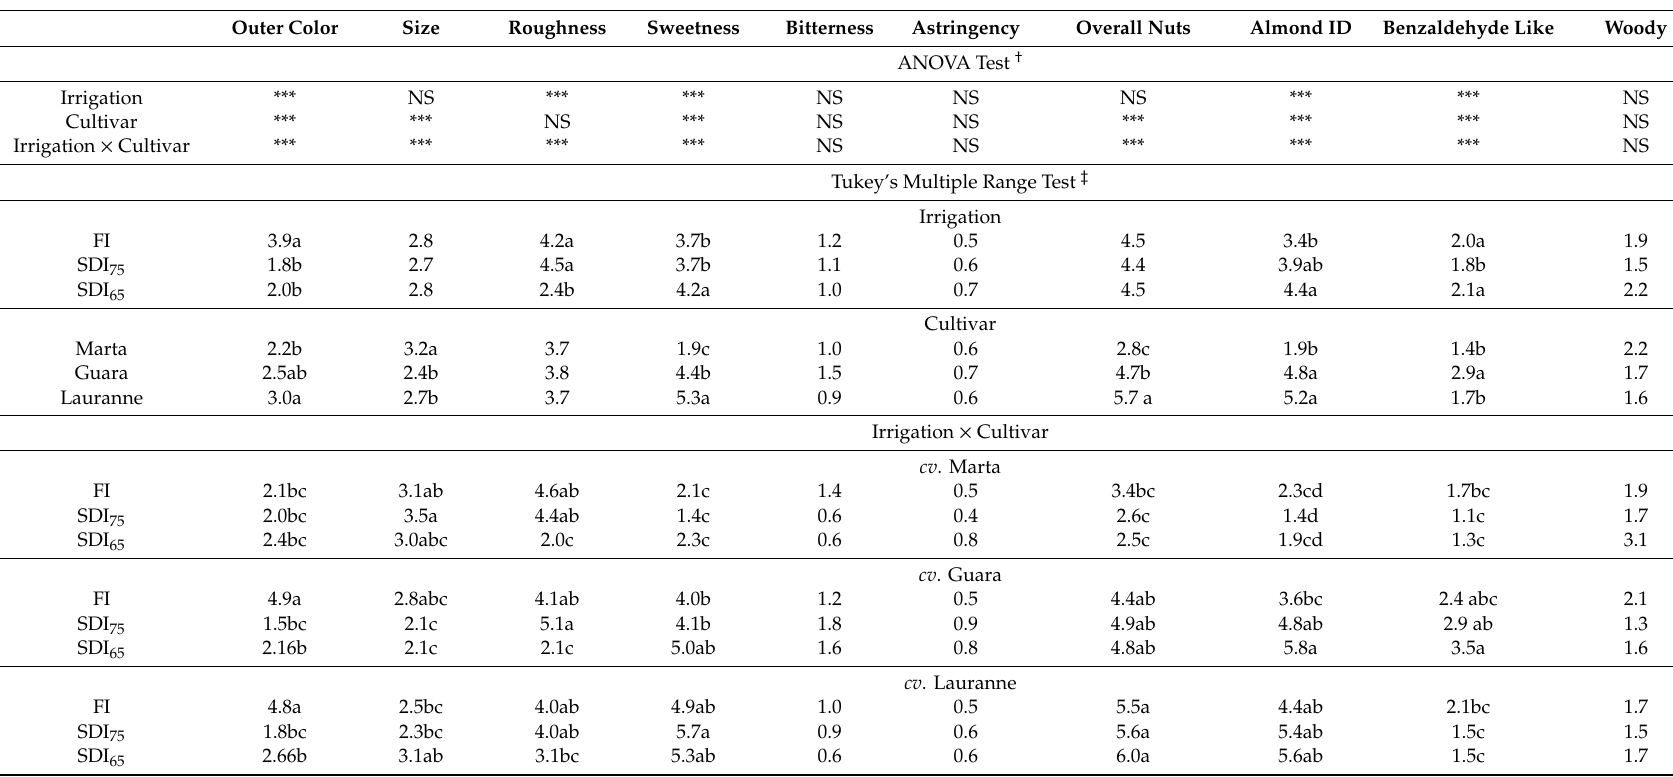
Table 7. Descriptive sensory analysis of raw almonds as a ff ected by deficit irrigation. Scale used ranged from 0 = no intensity to 10 = extremely strong intensity. Outer Color Size Roughness Sweetness Bitterness Almond ID Woody ANOVA Test †